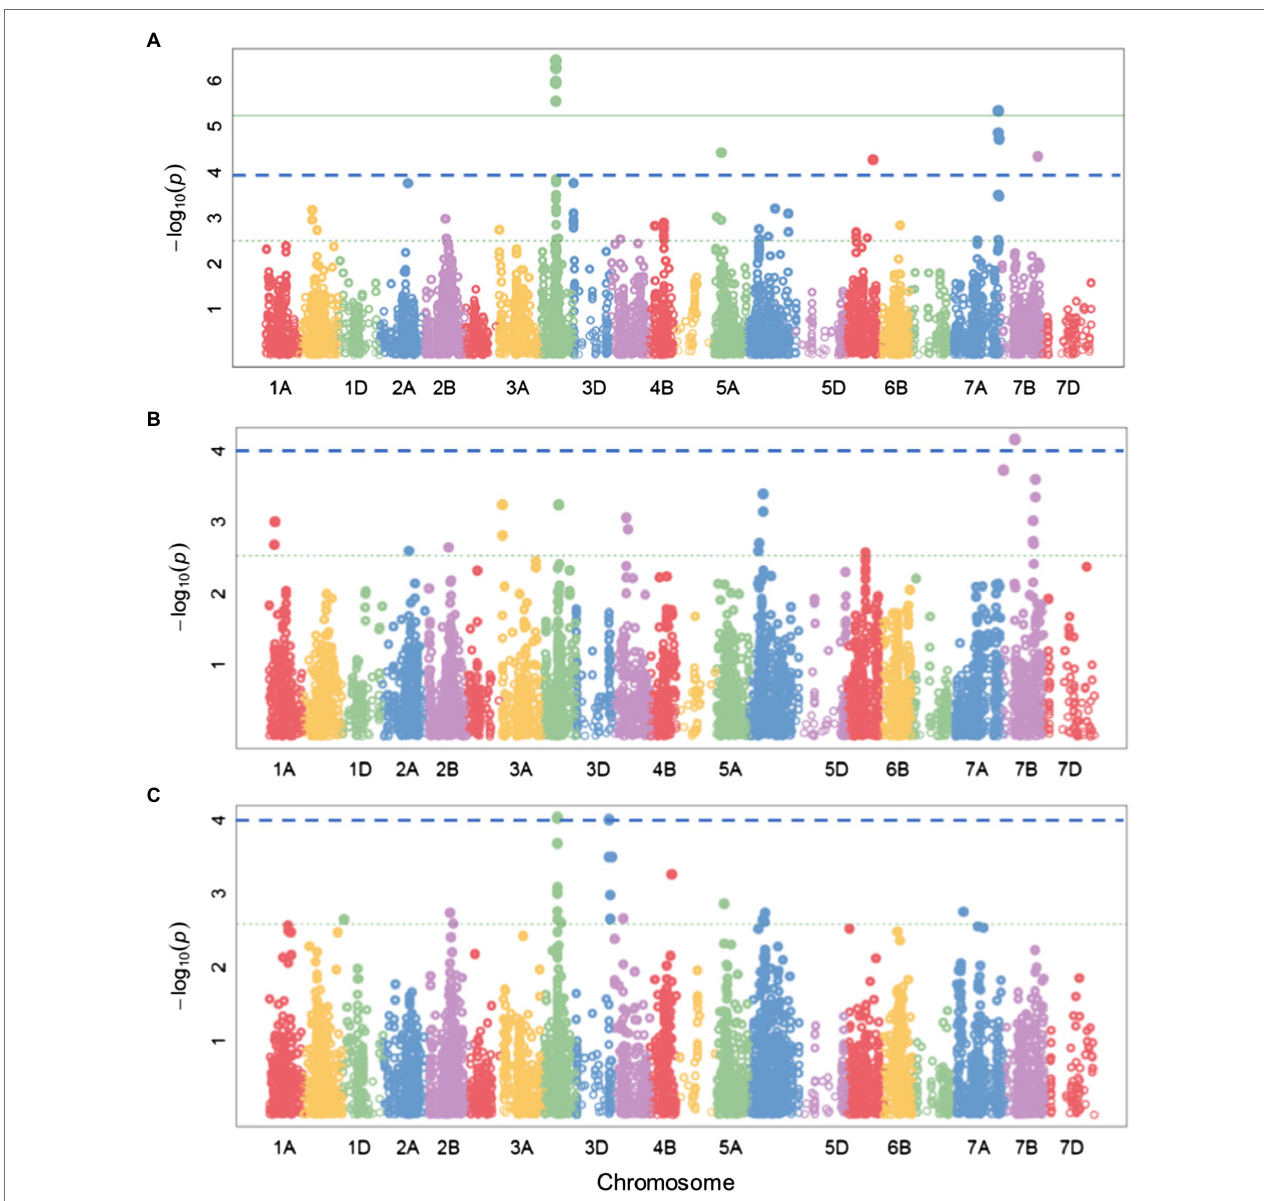
FIGURE 6 | Manhattan plots of AUDPC (FHB severity) identified with SUPER (A) combined set; (B) breeding set; and (C) genebank set. Green continuous and blue dashed horizontal lines represent Bonferroni corrected threshold at α = 0.05 and exploratory threshold at p = 0.0001,